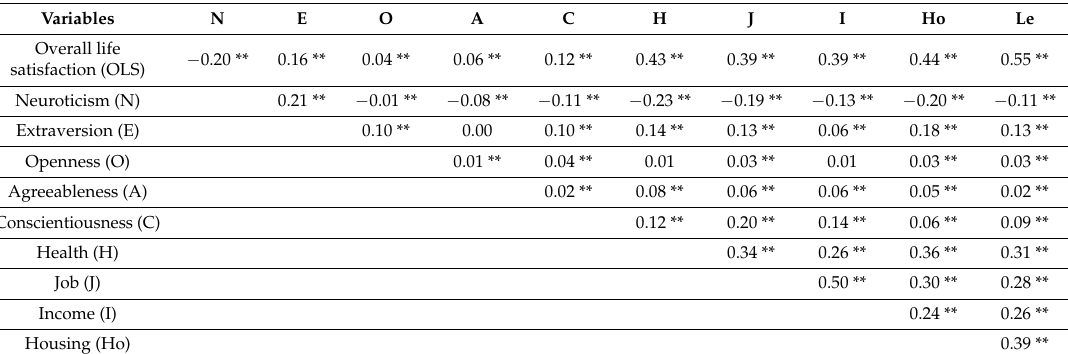
Table 2. Correlations of personality (BFI-10) and satisfaction variables for Survey 1. ( N = 40,297 except for variable job: N = 29,418).